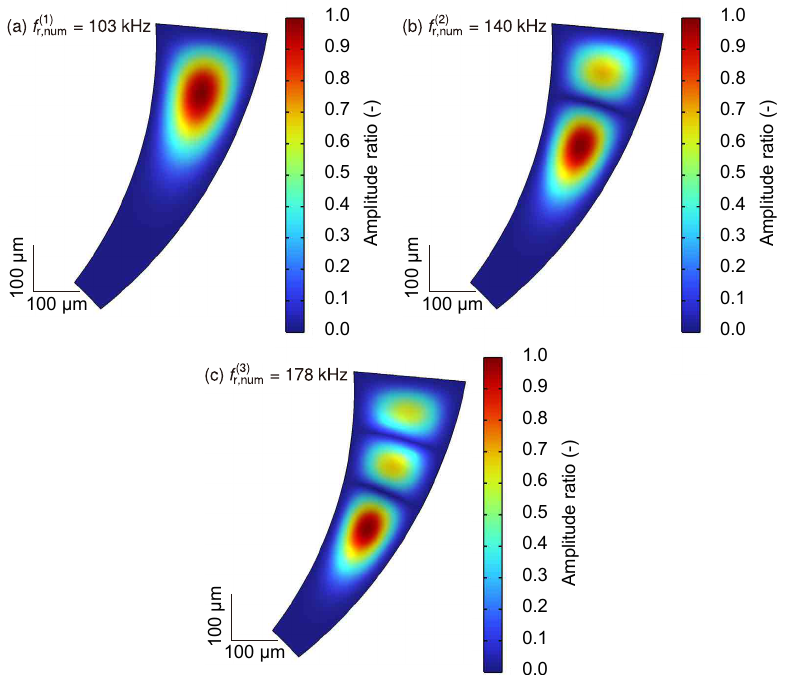
Figure 8. Numerical analysis of amplitude distribution in the xy plane for the miniaturized artificial cochlear sensory epithelium. Contours demonstrate the relative amplitude normalized by the maximum value of the oscillation amplitude for the natural frequency ( a – c ). Resonance positions indicated by the maximum amplitude are obtained for all eigenmodes. The device has different resonance positions based on the normal modes, and it is concluded that the miniaturized device has the function of frequency selectivity.